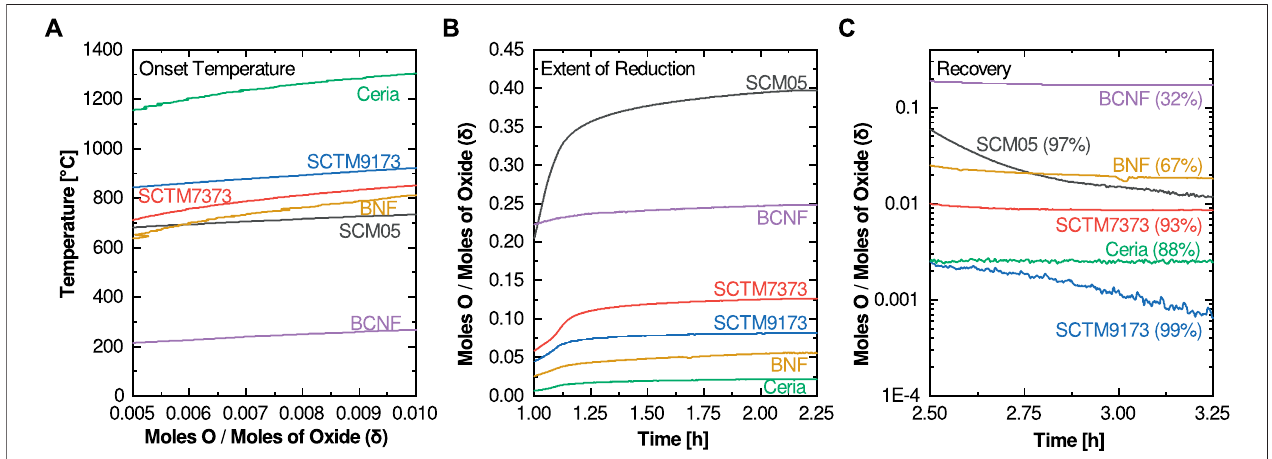
FIGURE2| Highlightplotsoftherelevantexperimentaldataregionsforthethree fi guresofmerit: (A) OnsetTemperature, (B) ExtentofReduction,and (C) Recovery (calculated percentage of reoxidation at 1,000 ° C is also listed).